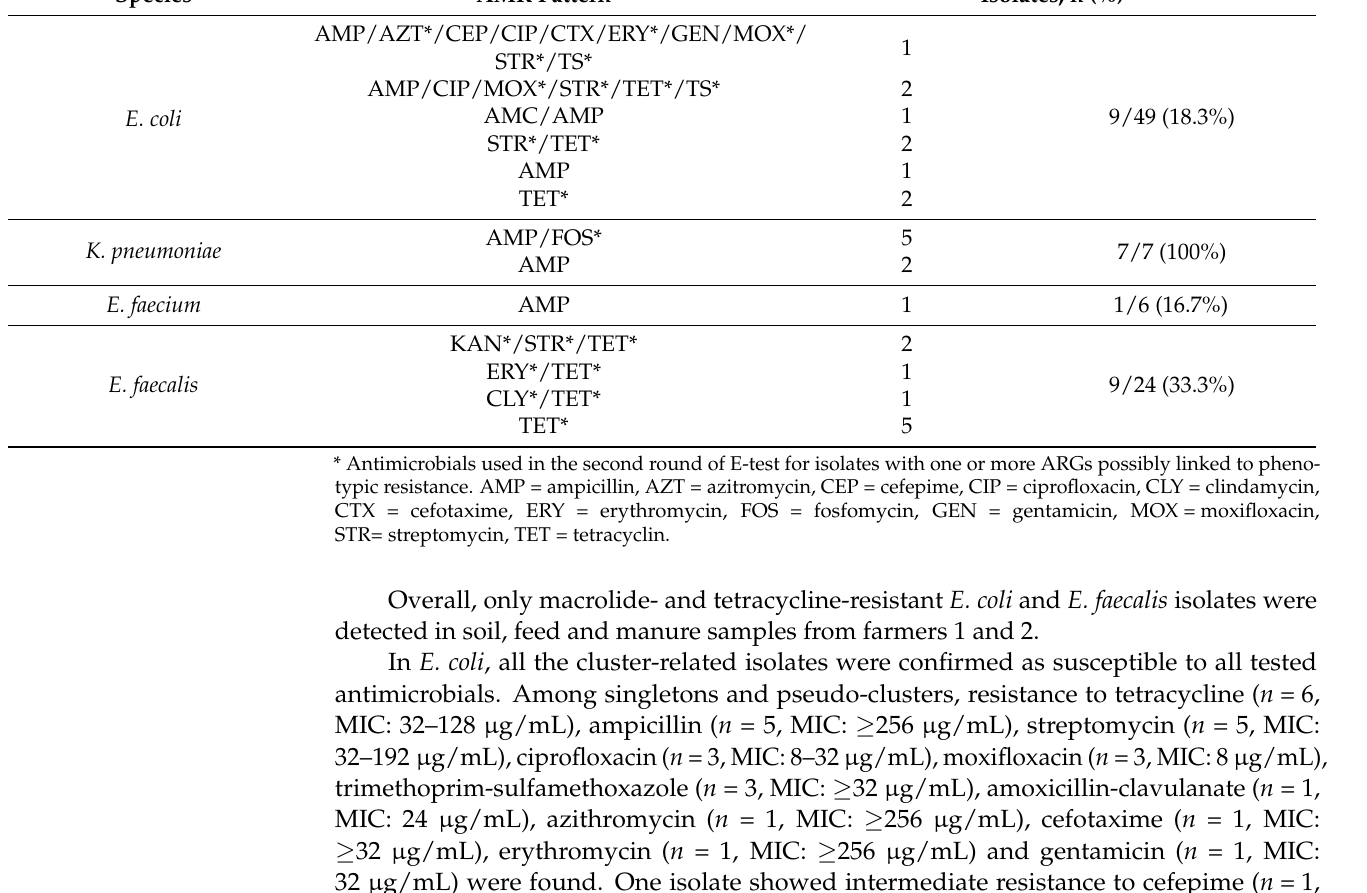
Table 2. Antimicrobial susceptibility patterns of the 26 isolates confirmed as resistant by E-test.